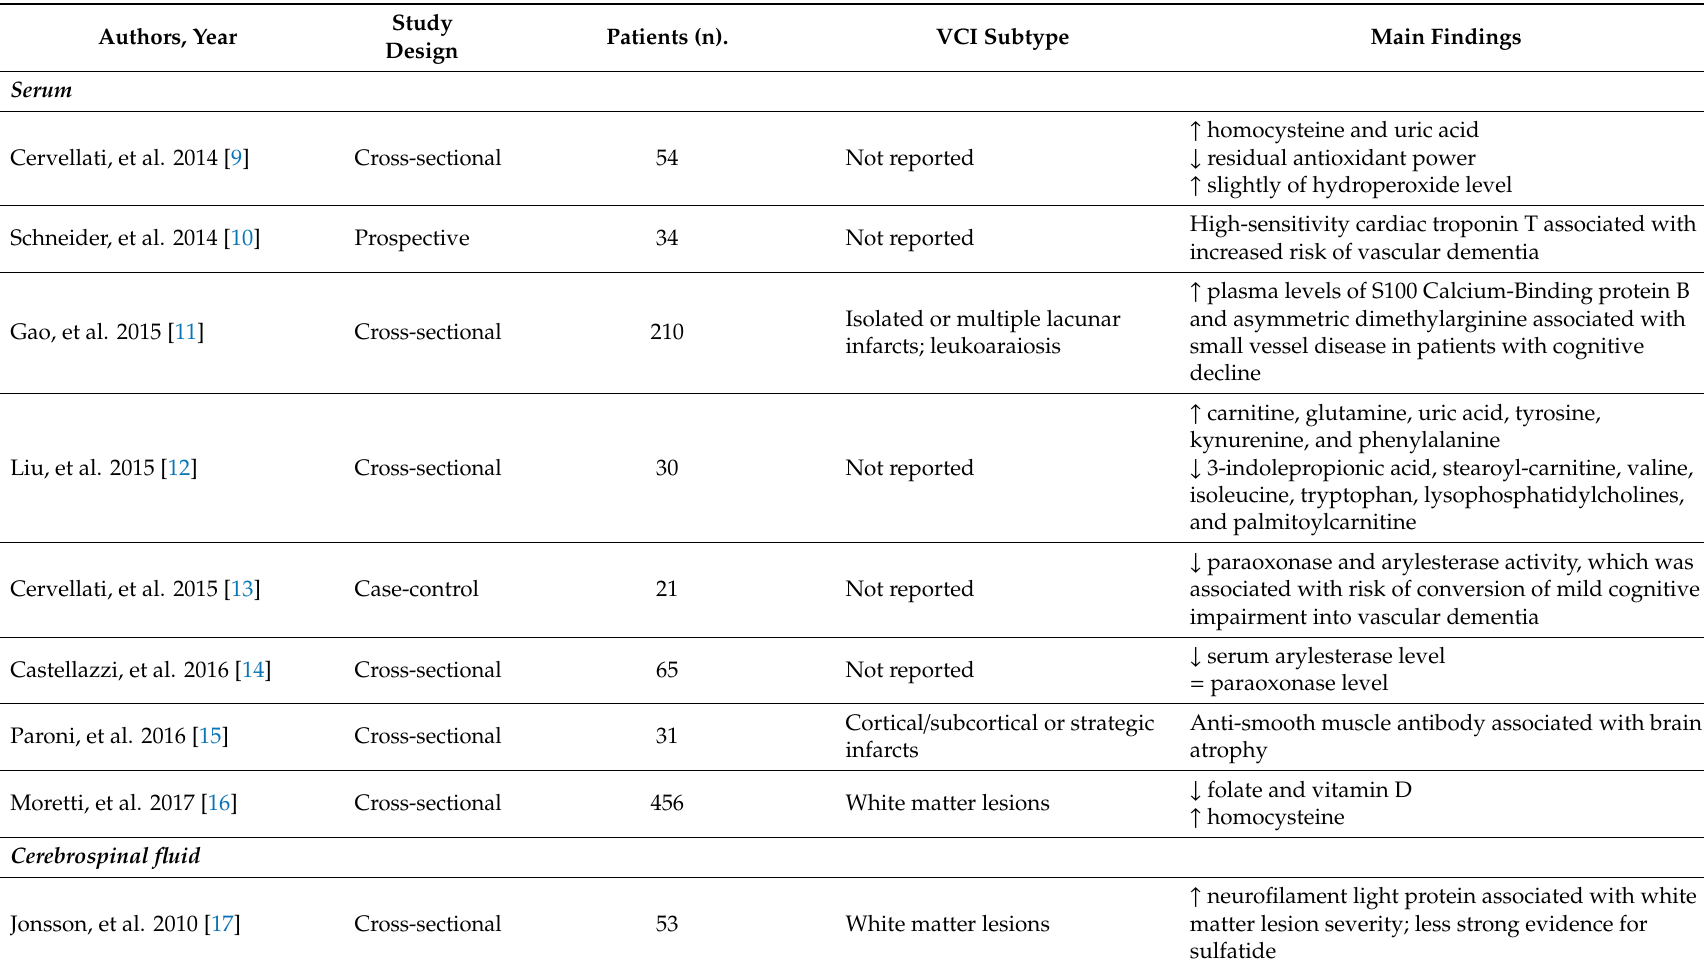
Table 1. Recent multidimensional studies on the neurobiology of vascular cognitive